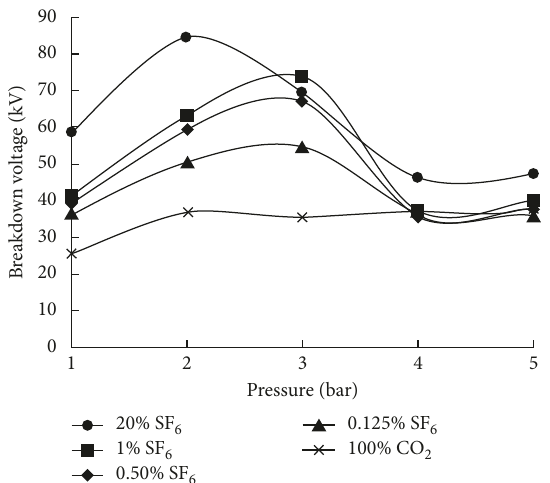
Figure 5: Changing of breakdown voltage with gas pressure for SF 6 -CO 2 mixtures.